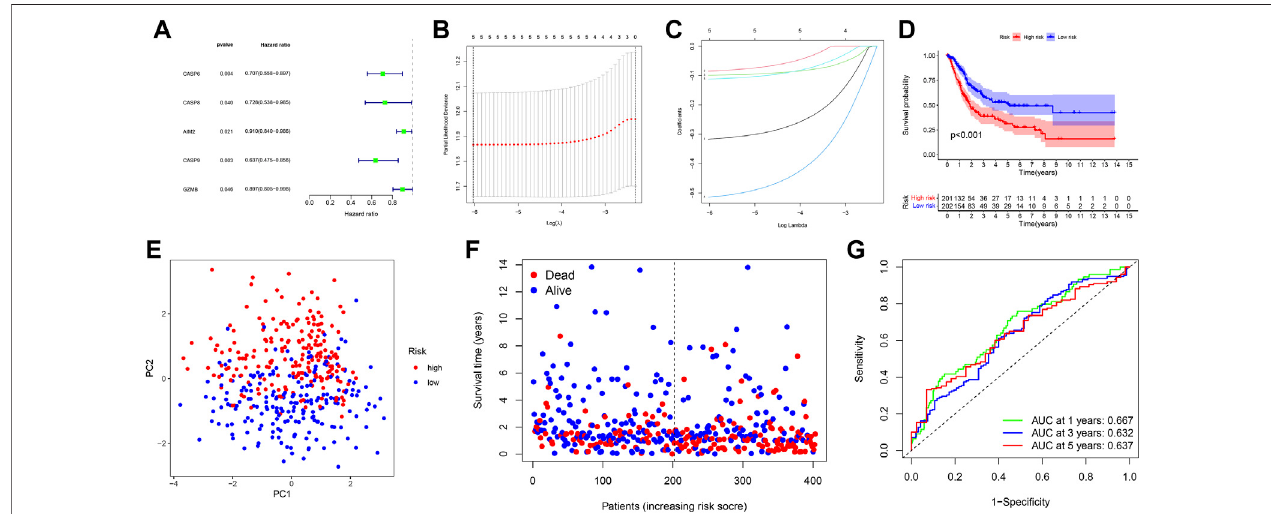
FIGURE 3 | (A) Forest plot shows that fi ve PRGs were potential prognostic factors for OS in univariate Cox survival analysis. (B) LASSO regression analysis of the fi ve PRGs. (C) LASSO regression analysis of the fi ve PRGs. (D) Kaplan – Meier curves for OS in bladder cancer patients ( n = 403) who had been strati fi ed into high- and low-riskgroupsbasedonthemedianriskscore. (E) PCAplotshowsthedistributionofhigh-riskandlow-riskgroups. (F) Distributionofthesurvivalstatusforthehigh-risk and low-risk groups. (G) ROC curves of 1, 3, and 5 years for the risk